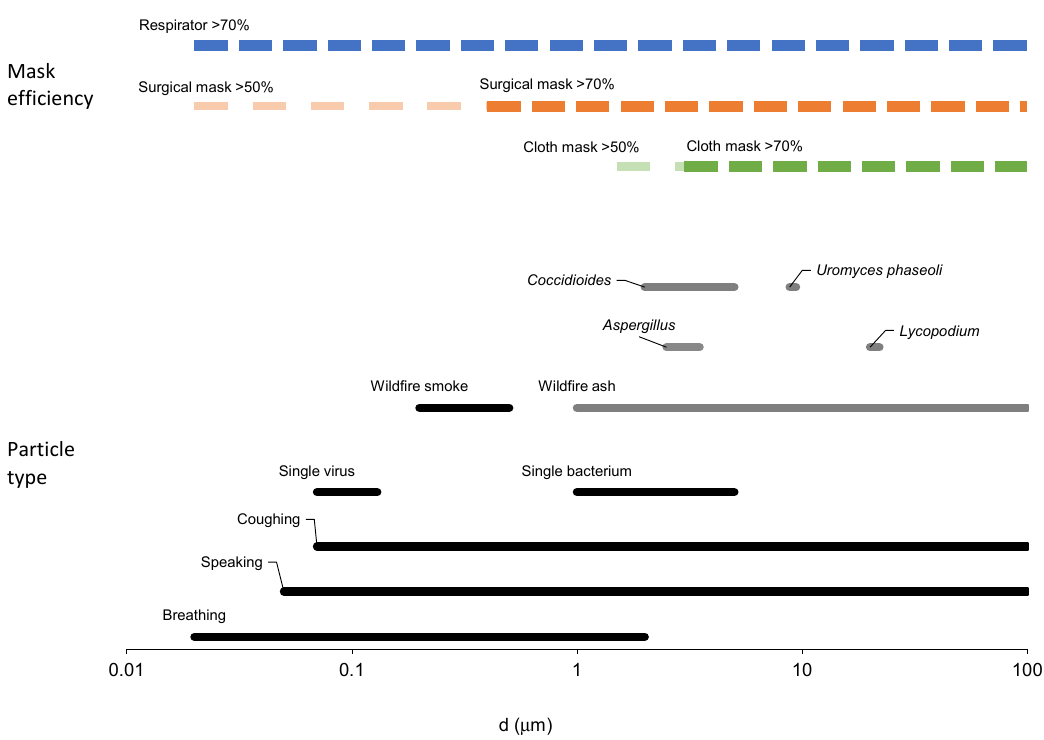
Figure 4. Collection efficiency E tot for four aerosol types, compared to calculations with breathing-emitted particles included in coughing and speaking size distributions (coarse dashed line), and calculations that neglect the 100 μ m particle modes of coughing and speaking (finely dashed line). Figure 5 shows the ranges in which different mask types are predicted to have >50% and >70% efficiency compared to different particle-type size ranges.